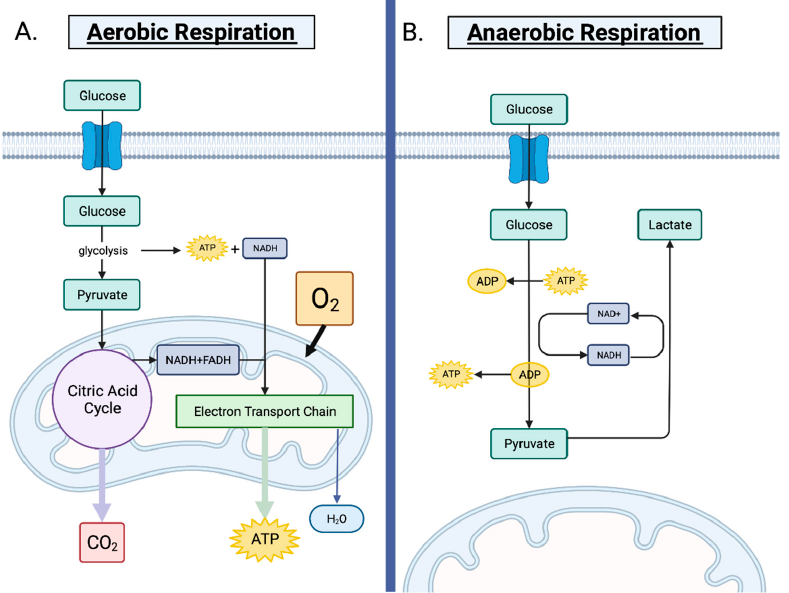
Figure 1. Aerobic respiration vs. anerobic respiration. ( A ). Normal, non-cancerous cells prefer aerobic respiration, which occurs in the presence of oxygen. The conversion of glucose to pyruvate is facilitated by glycolysis. The citric acid cycle then transforms pyruvate to acetyl-CoA in the mitochondria, also creating ATP, NADH and FADH. ATP is produced via oxidative phosphorylation of NADH and FADH, which fuels the electron transport chain. ( B ). When oxygen is scarce, cells switch to anaerobic respiration to generate ATP. Pyruvate cannot enter the citric acid cycle after glycolysis and is instead converted to lactate to avoid its accumulation. The NADH produced during glycolysis is converted back into NAD+, allowing glycolysis to continue. When oxygen levels return to baseline, cells resume aerobic respiration.